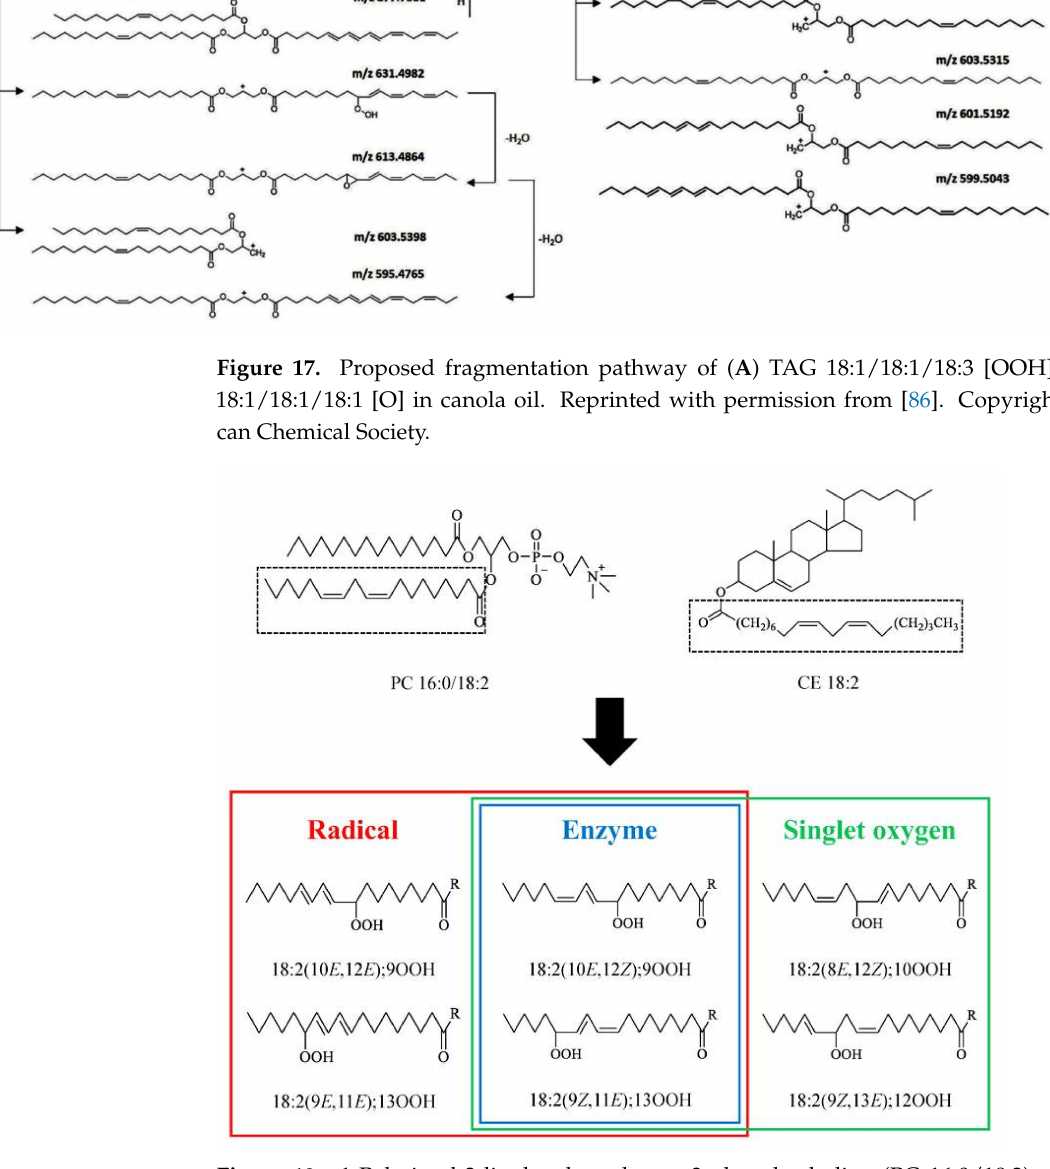
Figure 18. 1-Palmitoyl-2-linoleoyl- sn -glycero-3-phosphocholine (PC 16:0/18:2) and cholesteryl linoleate (CE 18:2) peroxidation mechanisms and the structures of their hydroperoxide isomers. PC 16:0/18:2 and CE 18:2 were oxidized to 1-palmitoyl-2-linoleoyl- sn -glycero-3-phosphocholine hydroperoxide (PC 16:0/18:2;OOH) and cholesteryl linoleate hydroperoxide (CE 18:2;OOH) isomers, respectively, by radical, enzymatic, and singlet-oxygen ( 1 O 2 ) oxidation